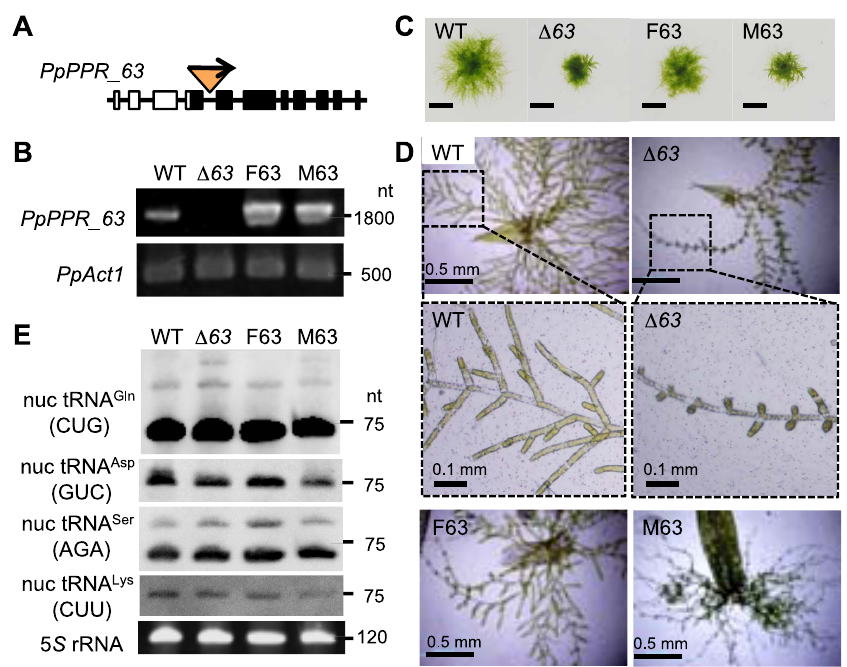
Figure 4. Molecular and morphological phenotypes of the PpPPR_63 KO and complementation mosses. ( A ) Schematic diagram of PpPPR_63 and construction of the KO locus. The nptII cassette was inserted into the 4th intron of the PpPPR_63 gene. ( B ) Detection of PpPPR_63 transcripts by RT-PCR. ( C ) Two-week-old protonemal colonies of the PpPPR_63 KO line ( D 63 ) and the complementation lines (F63 and M63). Bars =5 mm. ( D ) One-week-old filamentous protonemata regenerated from cut leaves. ( E ) Steady-state levels of nuclear-encoded tRNAs. (AGA) and tRNA Lys (CUU) levels were not affected in the mutants. This suggests that PpPPR_63 PNase P activity may be limited to specific tRNA(s) including tRNA Asp (GUC).